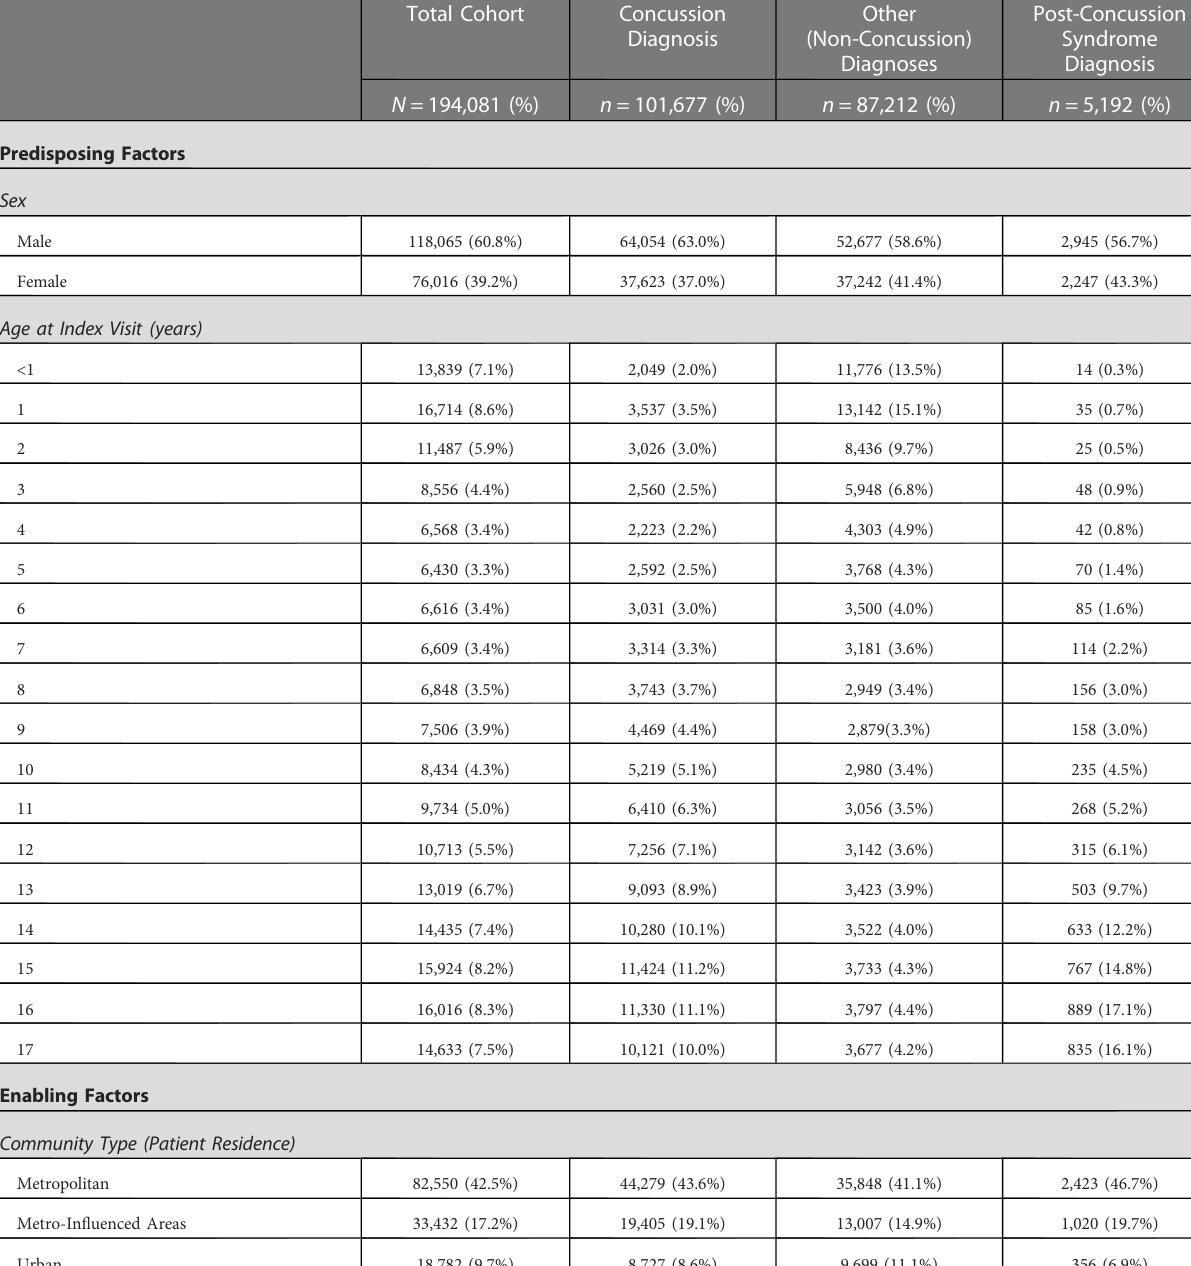
TABLE 2 Patient demographics for pediatric concussion, post-concussion syndrome, other speci fi ed injuries of head, and unspeci fi ed injury of head EOC occurring in ED or PO settings between April 1, 2004 and March 31, 2018 in